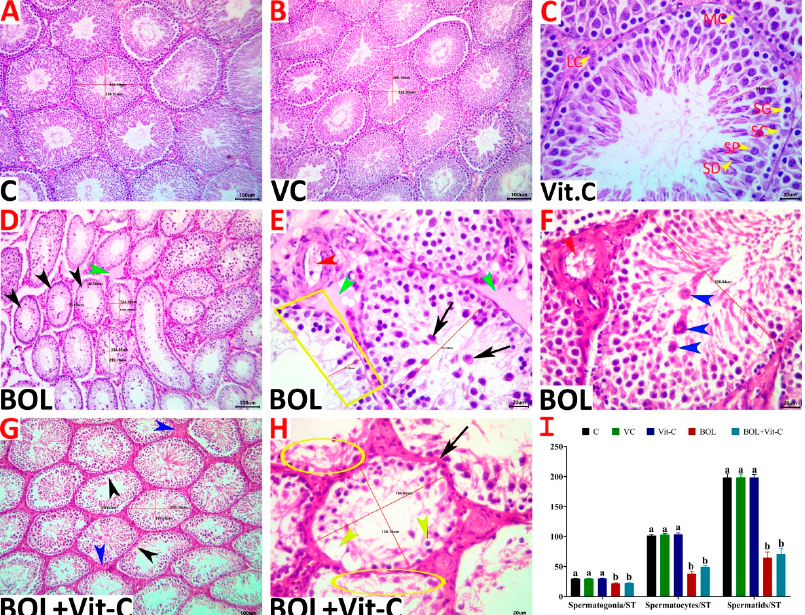
Figure 3. ( A – H ) Representative photomicrograph of H&E stained testicular tissue sections showing normal histological picture in control ( A ), vehicle control (VC) of sesame oil ( B ) and vitamin C (Vit-C) treated ( C ), treated rats (SG, spermatogonial cell; SP, spermatocyte; SD, spermatid; SC, Sertoli cell; LC, Leydig cell; MC, myoid cell). The boldenone (BOL)- treated group showed tubular degeneration/atrophy represented by increased numbers of ST/image, maturation arrest, germ cell depletion (trapezium), necrosis (black arrowheads), desquamated premature germ cells (black arrows), spermatid giant cells (blue arrowheads), and interstitial edema (green arrowheads), and congestion (red arrowheads) ( D – F ). The Vit-C-BOL-treated group showed vacuolated germ cells (yellow arrowheads), germ cell depletion (black arrowheads), germ cell necrosis (yellow ellipses), redundant basement membrane (black arrow), and increased interstitial tissue elements (blue arrowheads) ( G , H ). Scale bar is 100 microns for A , B , D , and E , and 20 microns for C . (I) Changes in numbers of germ cells in different experimental groups. Data are expressed as the mean ± SE ( n = 8 replicates). Columns carrying different superscripts (a,b) are significantly different (One-way ANOVA) ( p < 0.001).